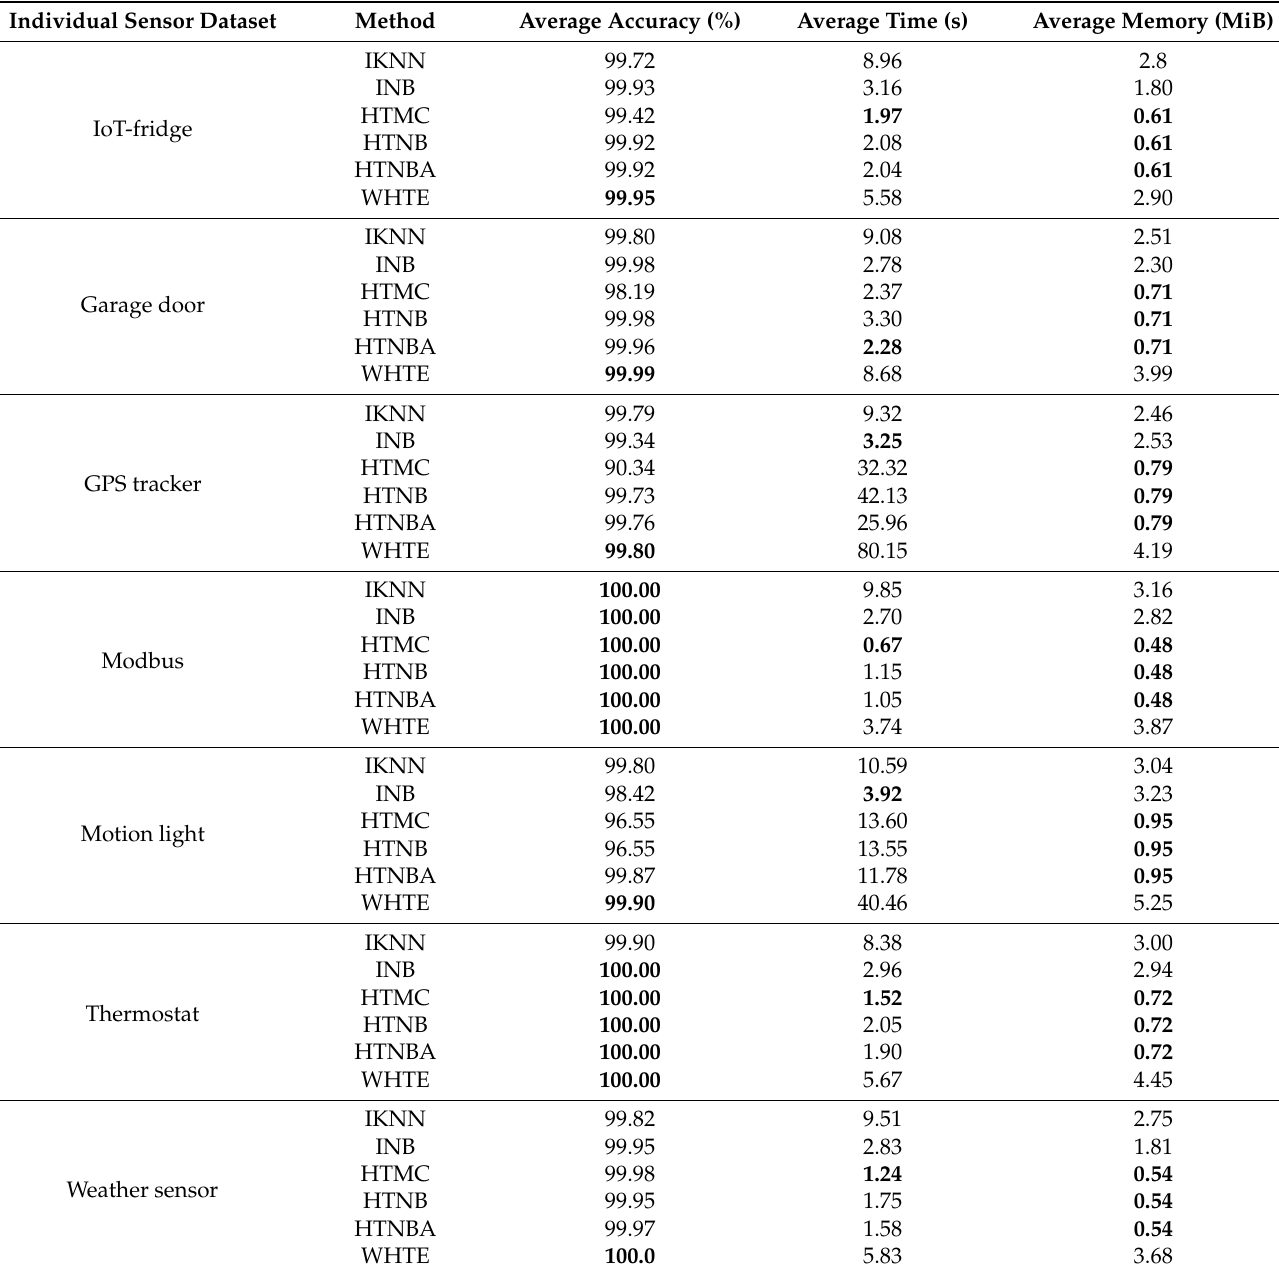
Table 3. The average accuracy, CPU time, and memory usage of the incremental learning methods applied on the ToNT- IoT